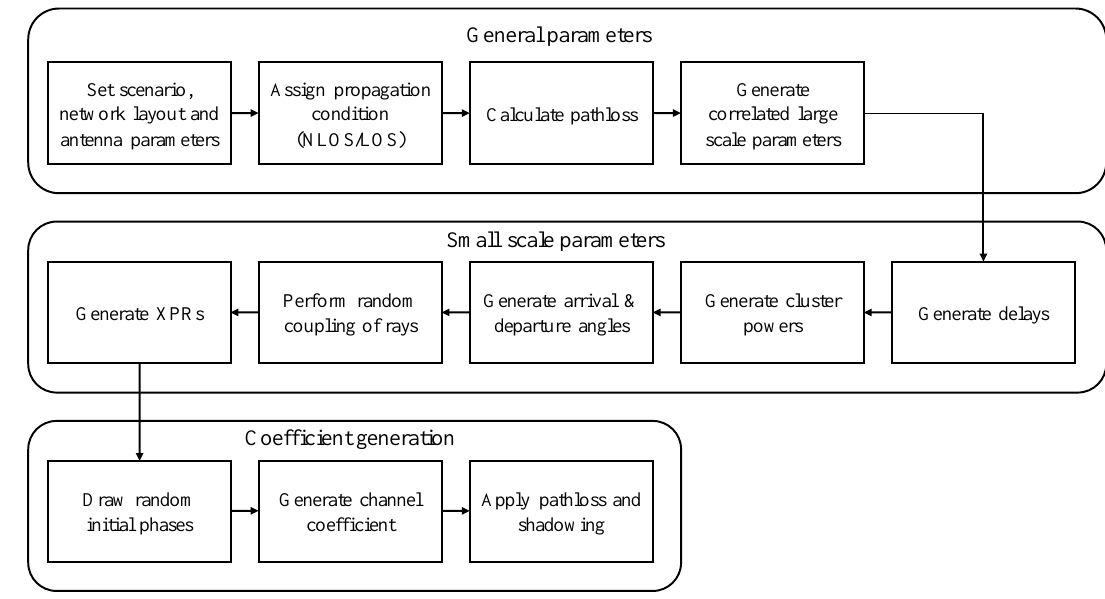
Figure 6. Channel model generation process in TR38.901.